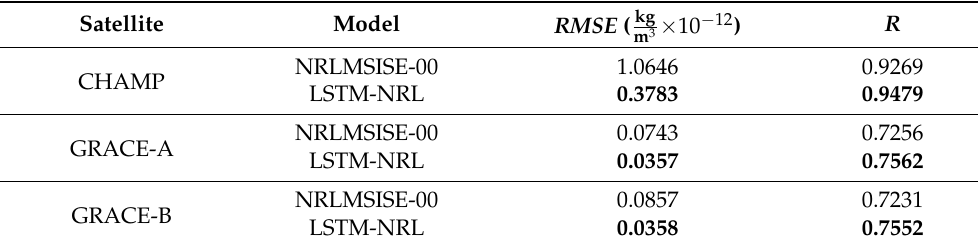
Table 9. The RMSE and R of the density series along the orbits of three satellites in January 2008. It is noted that the best results, in terms of RMSE and R , are bold in the table.